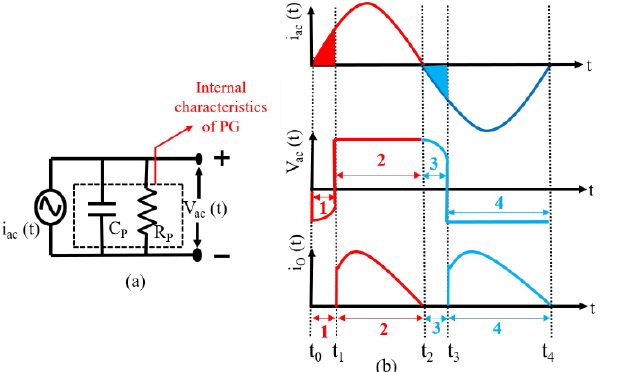
Figure 4. PG and associated waveforms. ( a ) PG representation as a current source and ( b ) current and voltage output of PG.